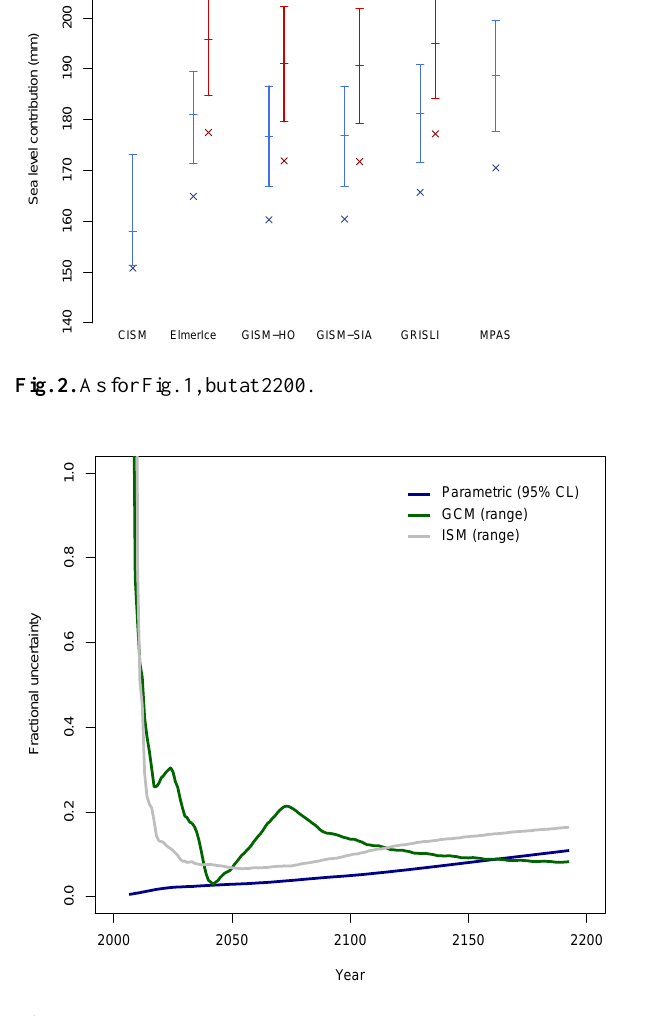
Fig. 3. Fractional uncertainties in projected cumulative GrIS sea level contributions for elevation feedback parameterisation (95% credibility interval divided by best estimate, averaged over ISMs and GCMs; GCMs (difference between ECHAM5 and HadCM3 di- vided by their mean, averaged over ISM best estimates; and ISMs (range of ISM best estimates divided by their mean, for ECHAM5 projections). A 15yr running mean is applied.